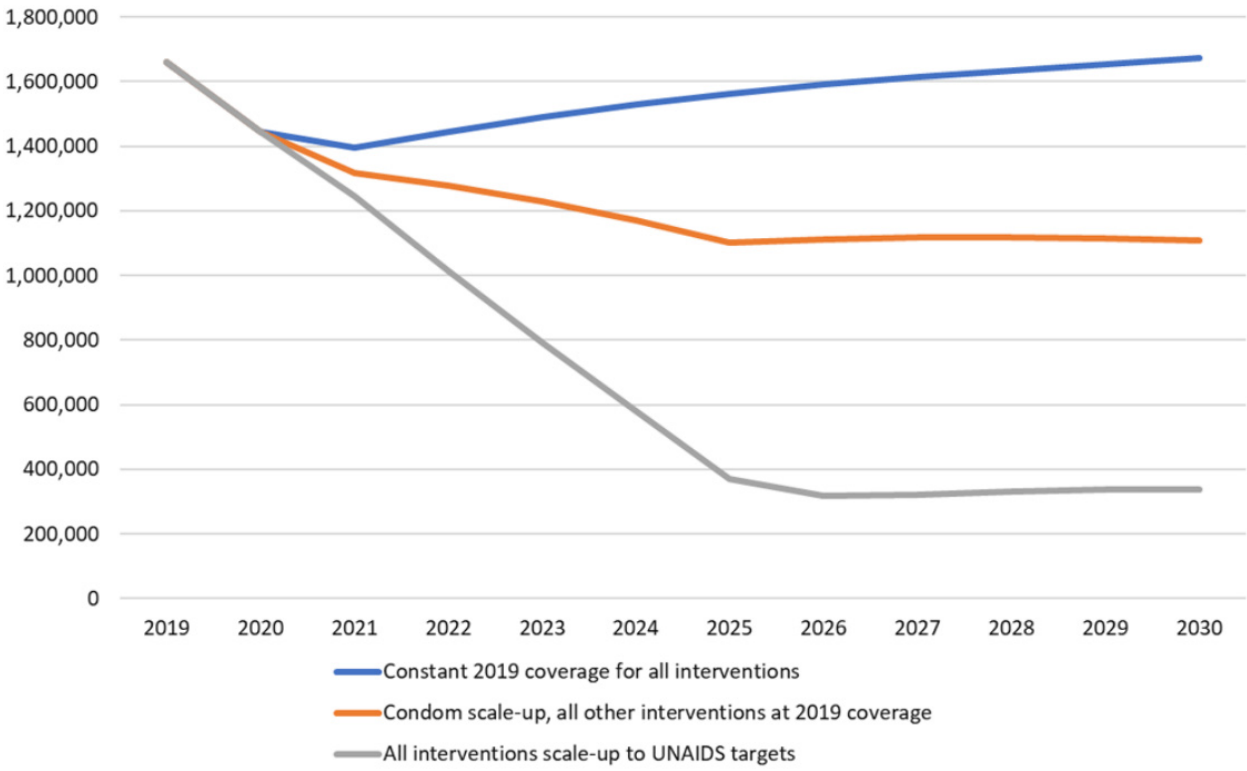
Figure 2. Number of new HIV infections in the future under three